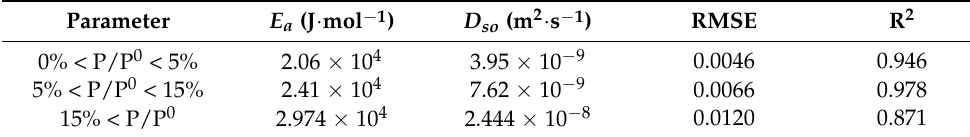
Figure 12. Adsorption kinetics experiment and fitted results at 34 °C. Table 4. SAPO-34 adsorption kinetic parameters with errors and statistical analysis.